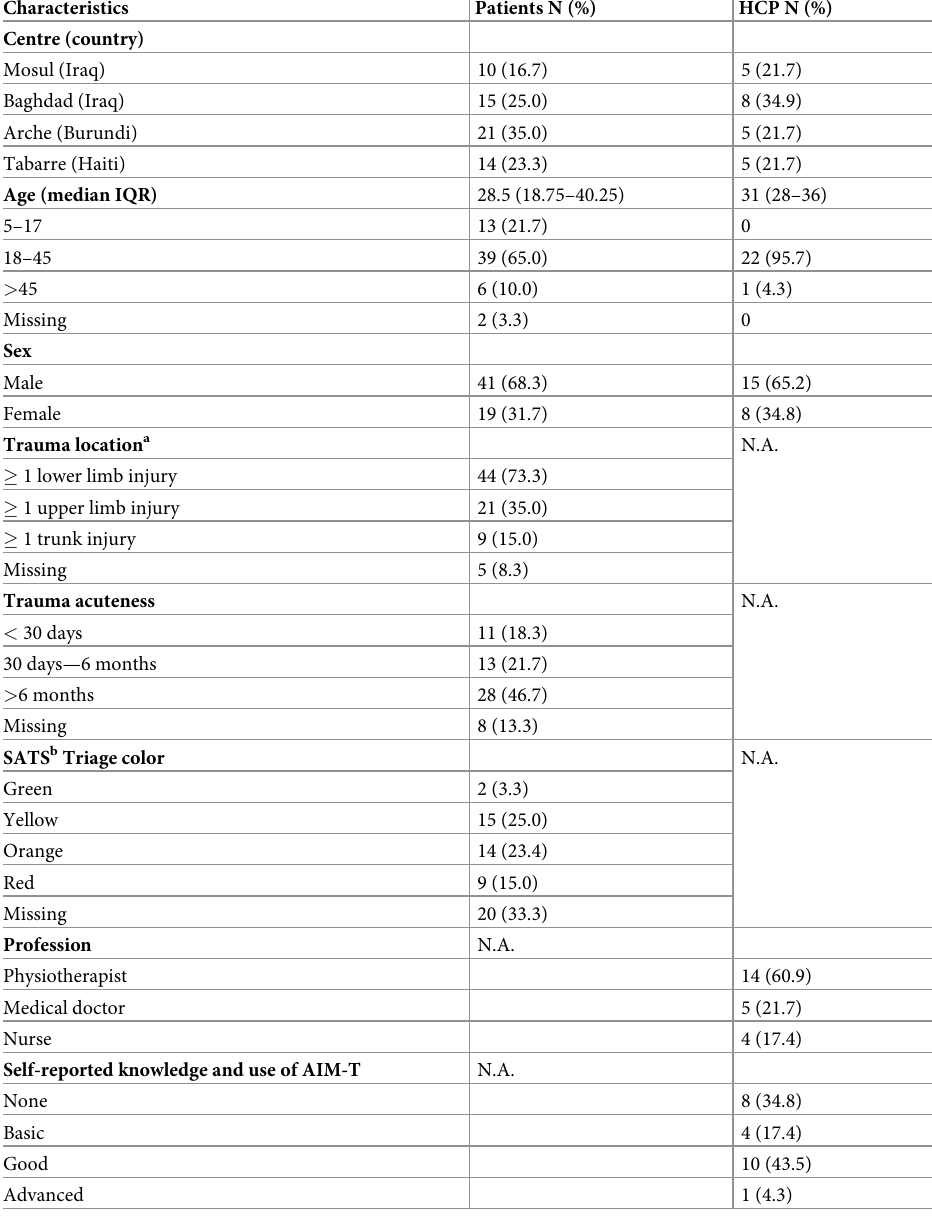
Table 2. Characteristics of interview participants for content validity; 60 patients and 23 health care professionals